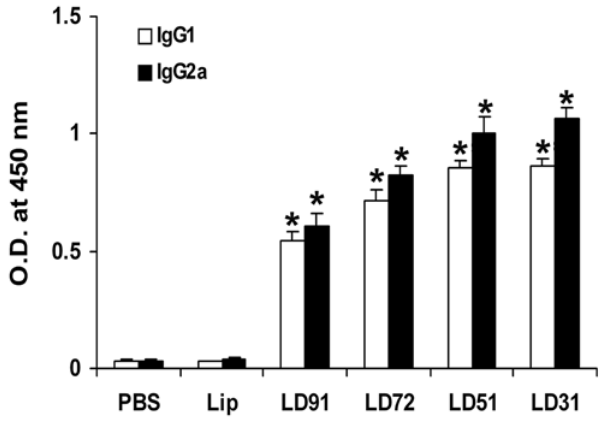
Figure 5. Prechallenge antigen-specific IgG isotype responses in BALB/c mice vaccinated with cationic liposomal antigens. Ten days after last vaccination serum samples were collected and assayed for antigen-specific IgG1 and IgG2a antibodies by ELISA. Each sample was examined in duplicate. The results are shown as the mean absorbance values 6 S.E. of five individual mice per group, representa- tive of two independent experiments with similar results. * p , 0.001 in comparison to control groups as assessed by one-way ANOVA and